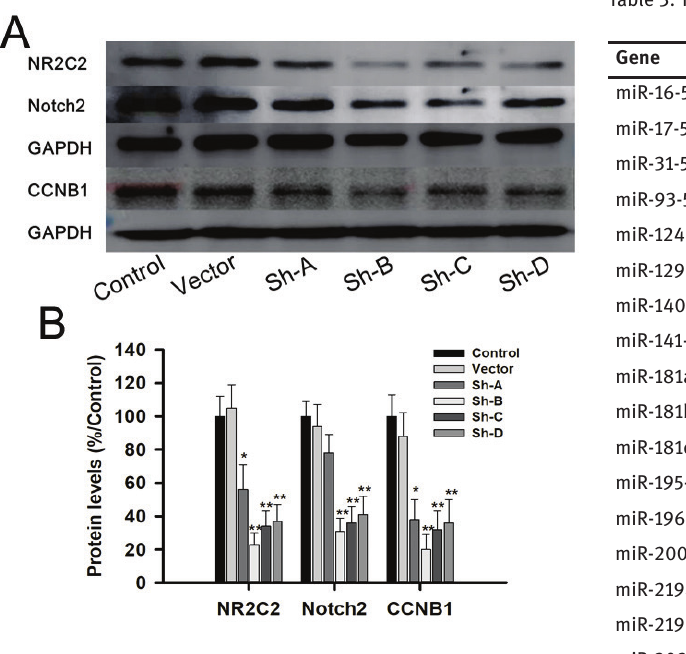
Figure 3: Knockdown of NR2C2 regulates the Notch2 and CCNB1 levels in MMQ cells. A: Western blot analysis show the NR2C2 level in Sh-B group and Sh-C group reduced to 23% , 34% compared to Control group separately. B: The statistic of western blot. GAPDH was used for normalization.